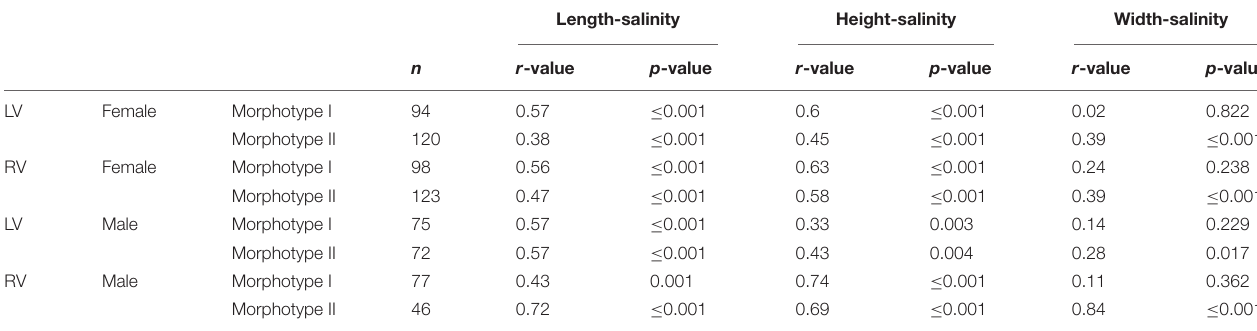
TABLE 5 | Regression coefficients of log-transformed size and salinity data for females and males left (LV) and right valves (RV).